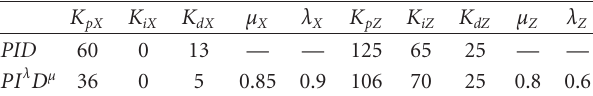
Table 3: PID and PI λ D μ controller